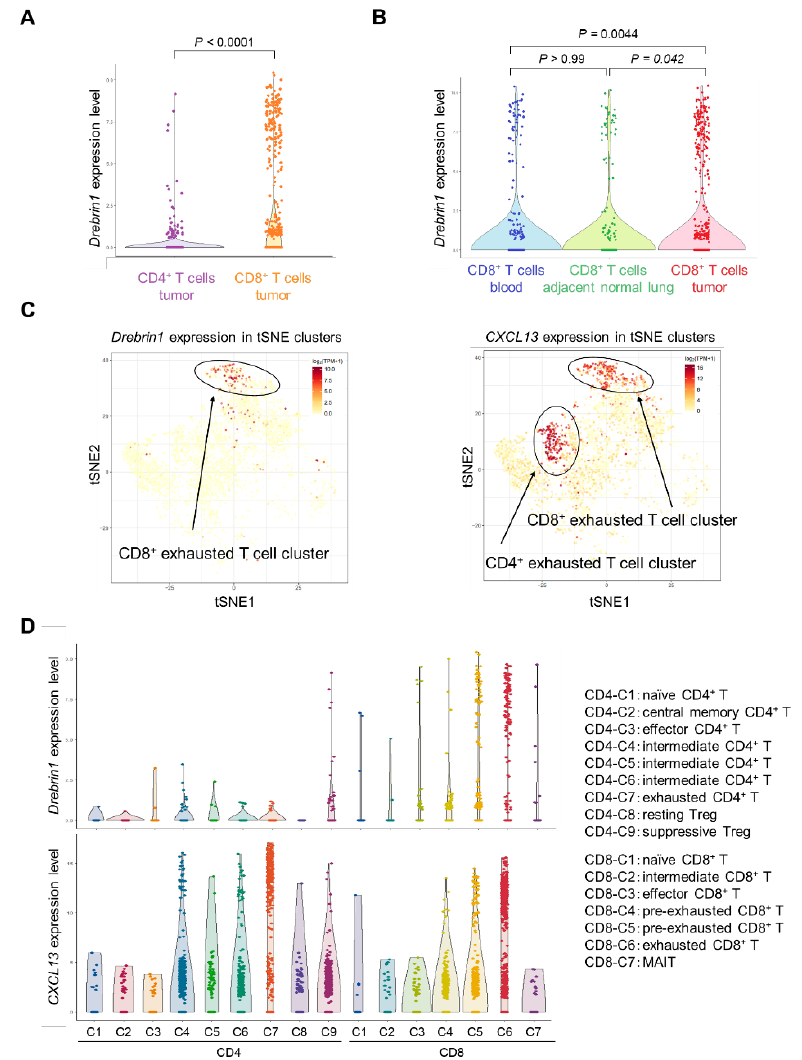
Figure 6. Transcriptional characterization of drebrin + T cells in NSCLC patients. ( A ) Comparison of drebrin1 levels between CD4 + and CD8 + T cells. Each dot represents one cell. ( B ) Comparison of drebrin1 levels between different tissue samples. Each dot represents one cell. ( C ) Expressions of drebrin1 and CXCL13 in T cells from the tumor are illustrated in the t-SNE plots. Each dot represents one cell. ( D ) Expressions of drebrin1 and CXCL13 in each cluster are illustrated in violin plots. Each dot represents one cell. The definition of each cluster is indicated on the right panel. Intermediate cells represent cells bridging naïve, effector, and exhausted clusters. MAIT, mucosal-associated invariant T cells; NSCLC, non-small-cell lung cancer; t-SNE, t-distributed stochastic neighbor